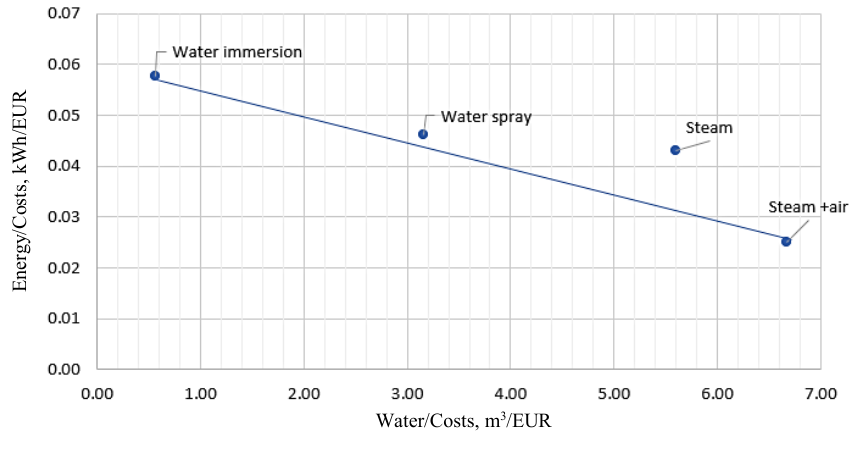
Fig. 2. Efficiency frontier for various sterilization